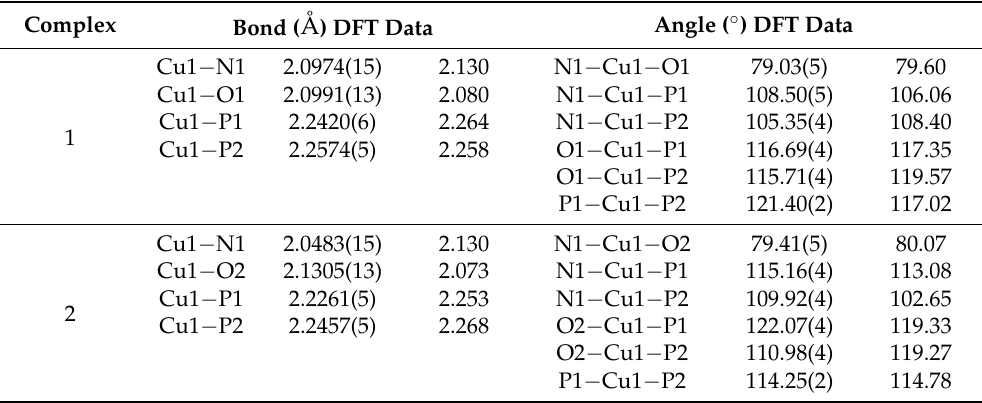
Table 2. Experimental (scXRD) and calculated (DFT M06/6-31G(d)+DZVP level) values of selected bond lengths